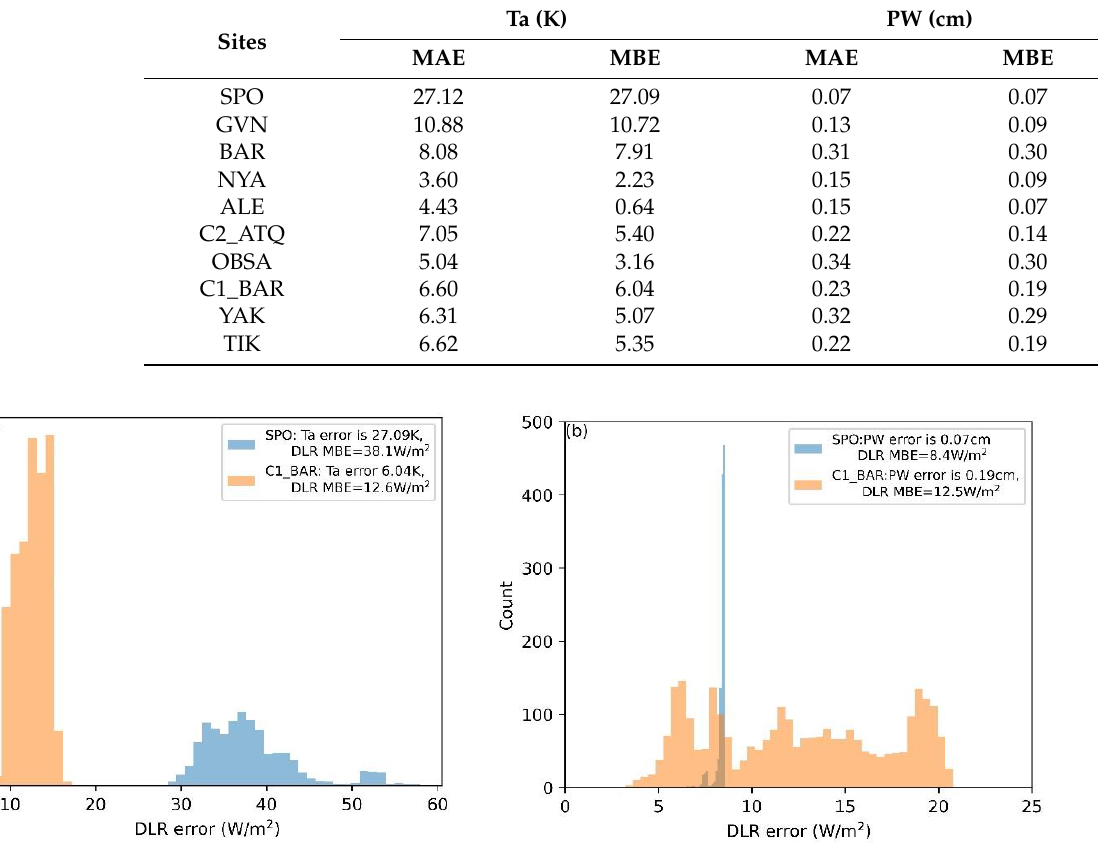
Figure 7. The histogram of DLR error that caused by the error of Ta ( a ) and PW ( b ) at SPO and C1_BAR sites. DLR error is the calculated DLR with wrong input parameter minus the true DLR.